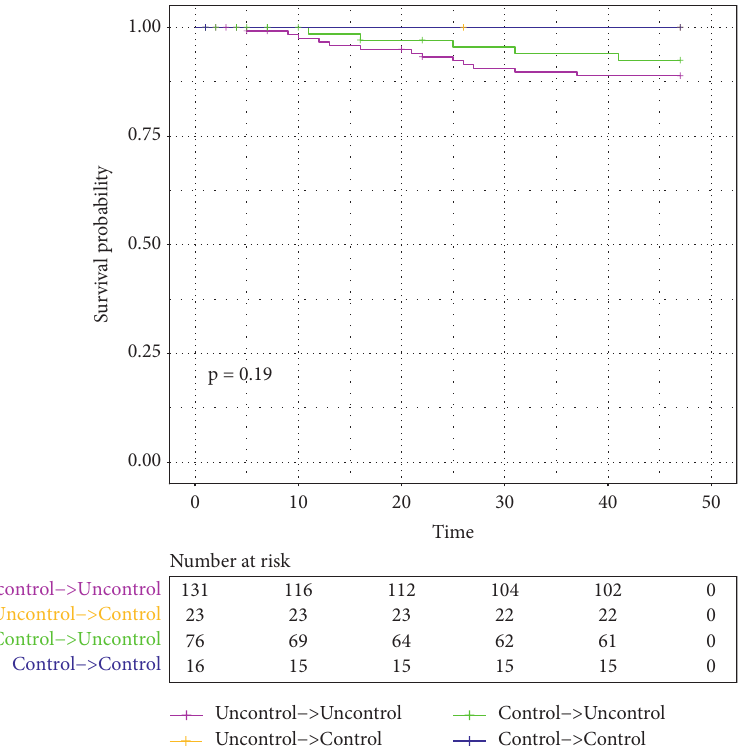
Figure 4: Changes in risk factor control and time to all-cause mortality in patients with hypertension and newly diagnosed diabetes. Table 3: Univariate Cox analysis of factors associated with all-cause mortality in patients with hypertension and newly diagnosed diabetes after 4